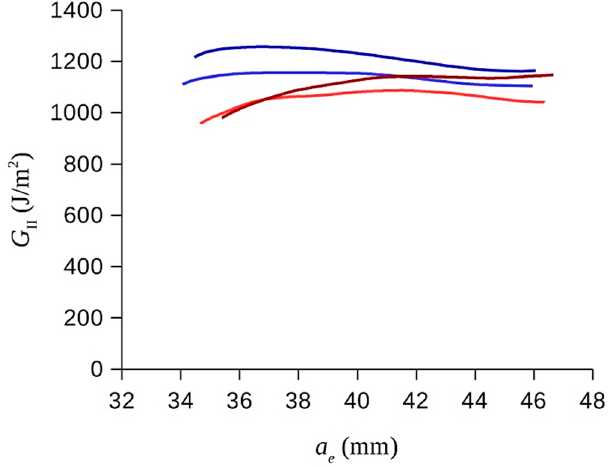
Figure 6. Typical R-curves measured from the insert (blue lines) and fatigue pre-crack (red lines).